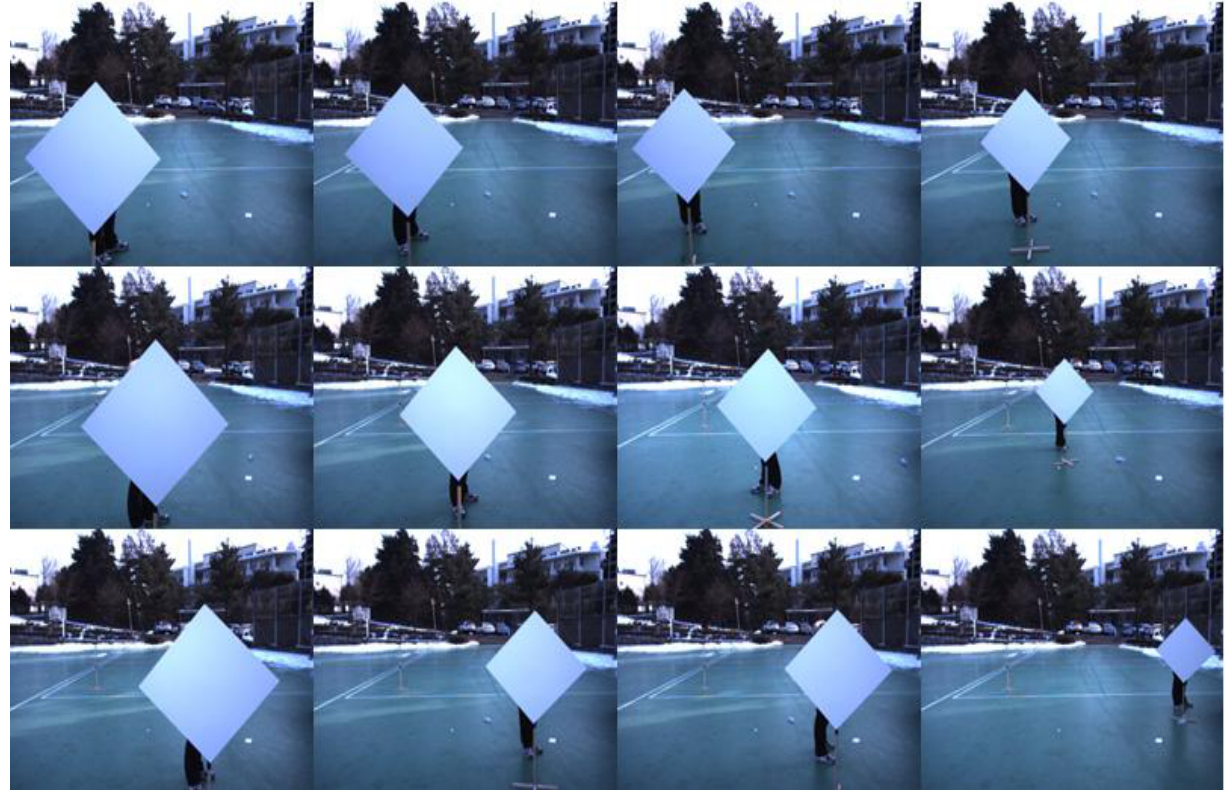
Figure 12. Diamond boards with 12 different positions: the distances from the camera to the board are 1.7 m, 2.2 m, 3 m and 5~7